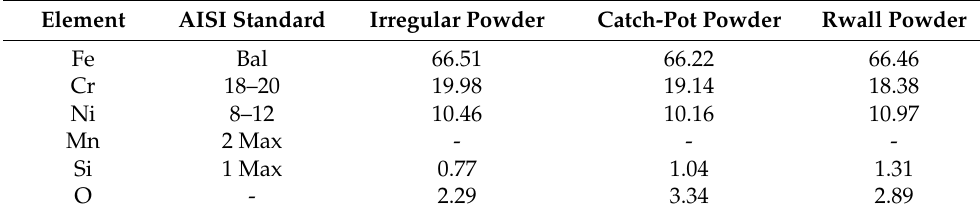
Figure 6. Micrographs showing cross-section of AISI 304 SS powder for irregular feed powder ( a , b ) −63 µm and +63–106 µm and for spheroidised powder from catchpot ( c , d ) for −63 µm and +63–106 µm size powders. Table 4. The elemental composition, in wt.%, of the steel and foreign objects detected in the reac- tor